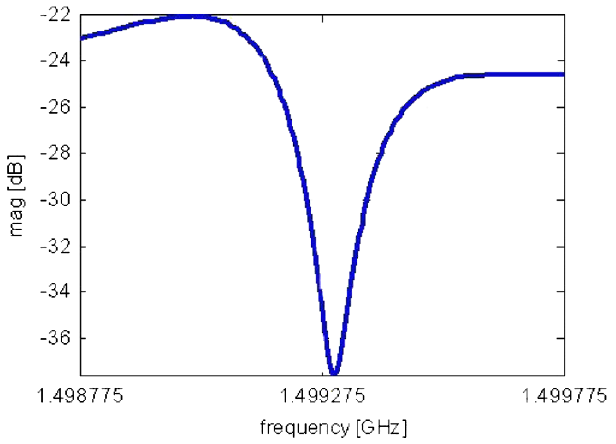
FIG. 10. (Color) S 11 at the HJ input port connected to the klystron after